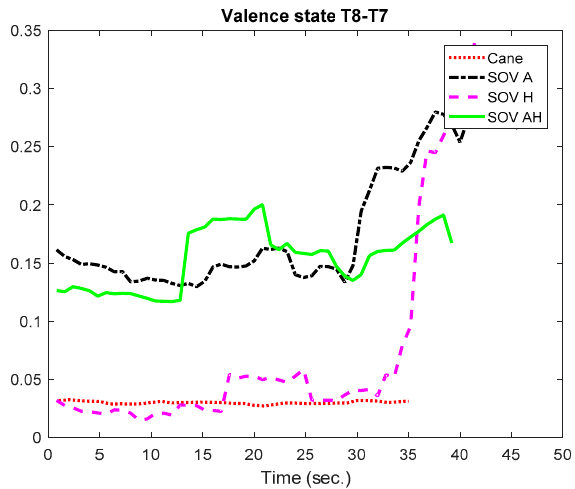
Figure 33. VS evolution in time for UserA.